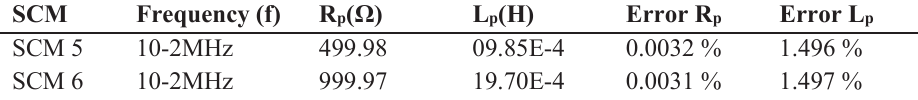
Table 2: Impedance parameters and errors calculated by LEBISDI for the inductive circuit models (ICM) studied.